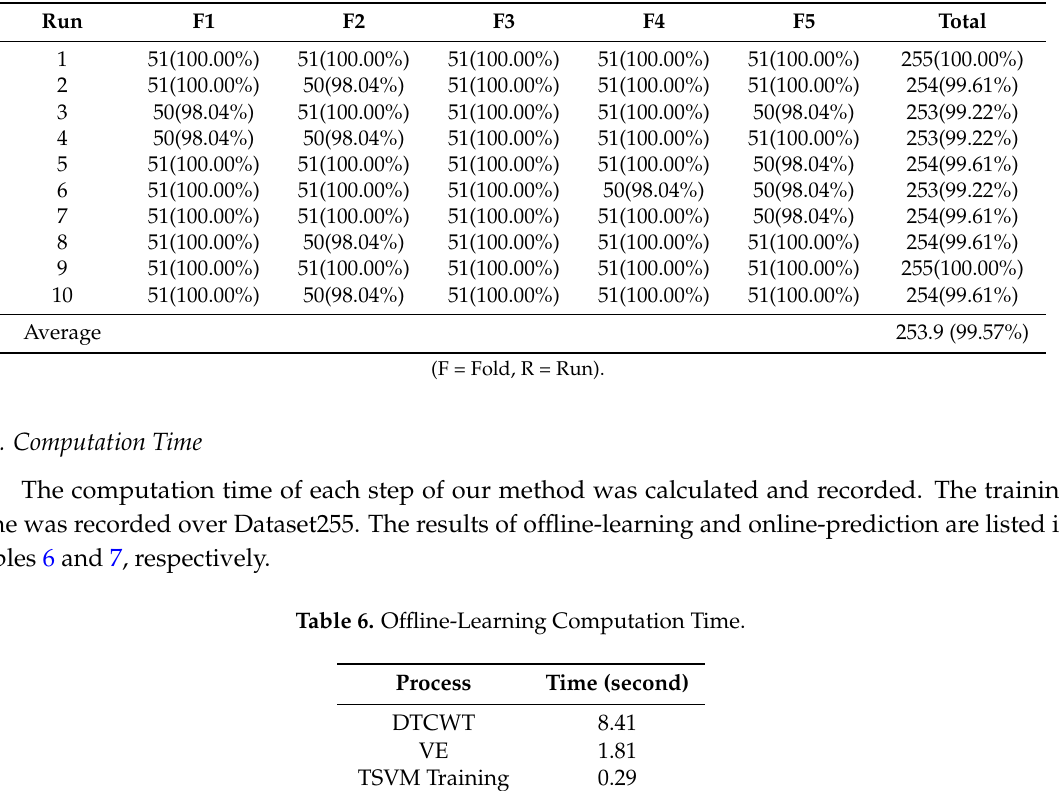
Table 5. Detailed Results of DTCWT + VE + TSVM over Dataset255.